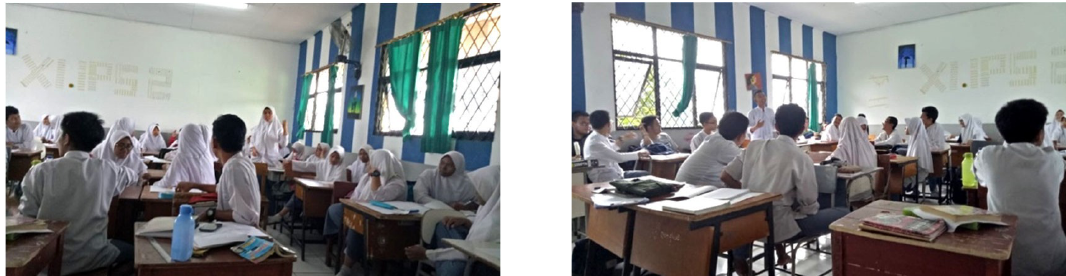
Figure 3. Classroom discussion about the plastic